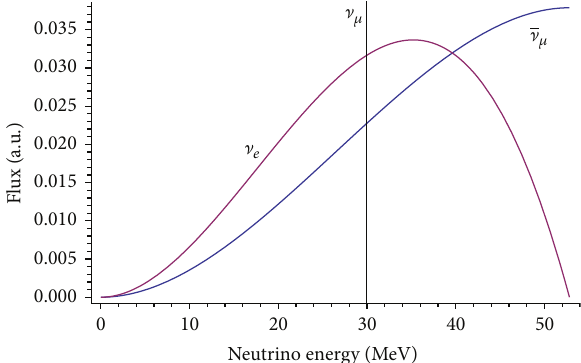
Figure3:Neutrinofluxdistributionfromapion/muonDARsource, from